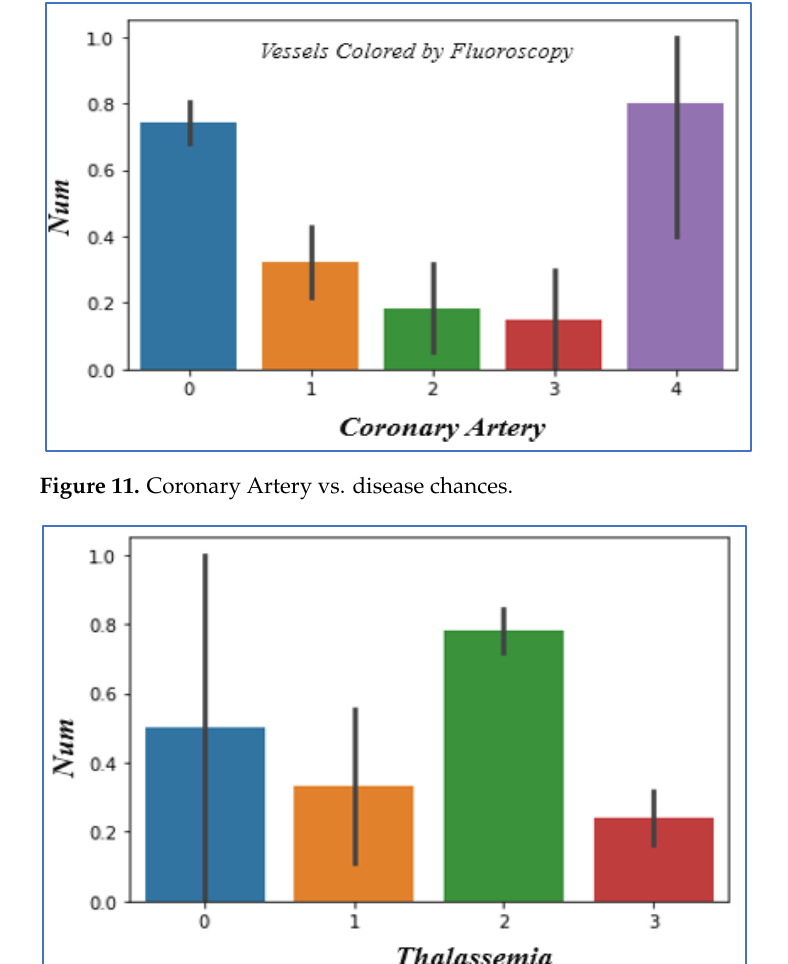
13 of 19 Figure 10. Slope vs. heart disease chances.